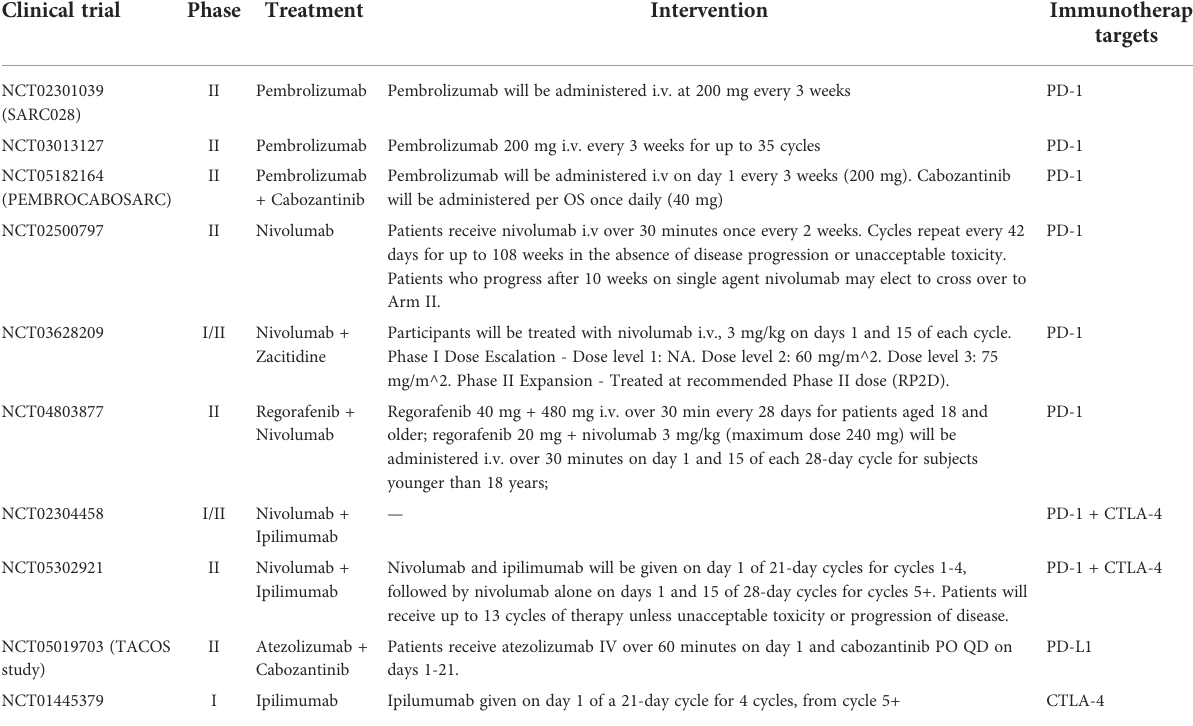
TABLE 6 Clinical trials of immune checkpoints inhibitors for patients with osteosarcoma. Clinical trial Phase